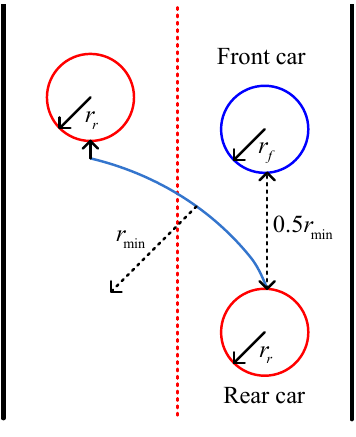
Figure 5. Steering basis of vehicle.